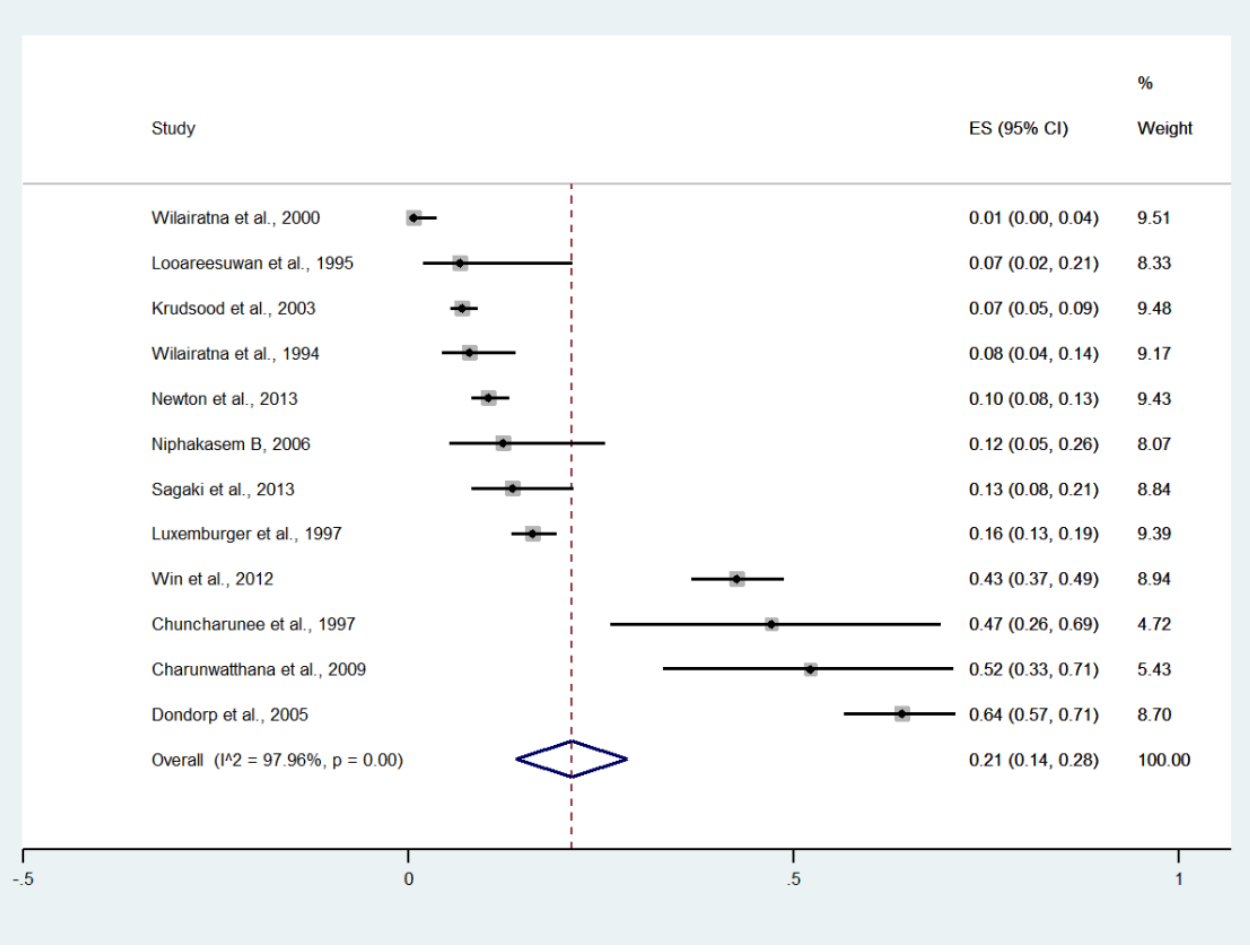
Figure 6. The pooled prevalence of impaired consciousness among patients with severe malaria in Thailand. The label for the x-axis is the scale of estimated prevalence. Abbreviations; ES, estimated prevalence; CI, confidence interval .